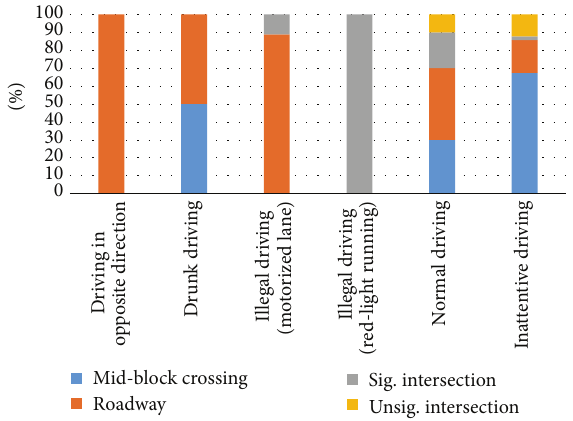
Figure 3: Breakdown of crash locations for precrash behaviors of e-bike